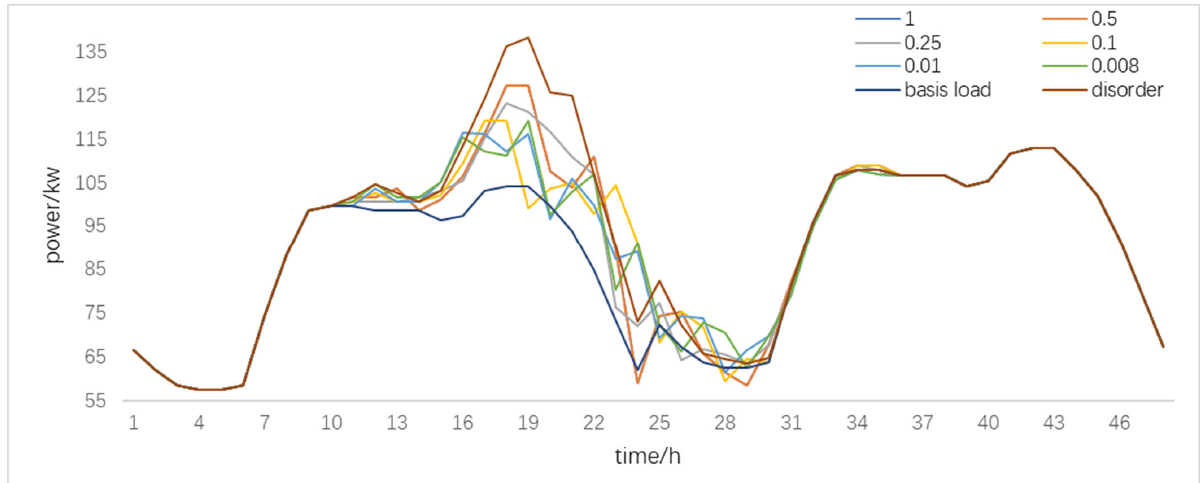
Figure 6. Load fluctuations. Table 3. Data results with different